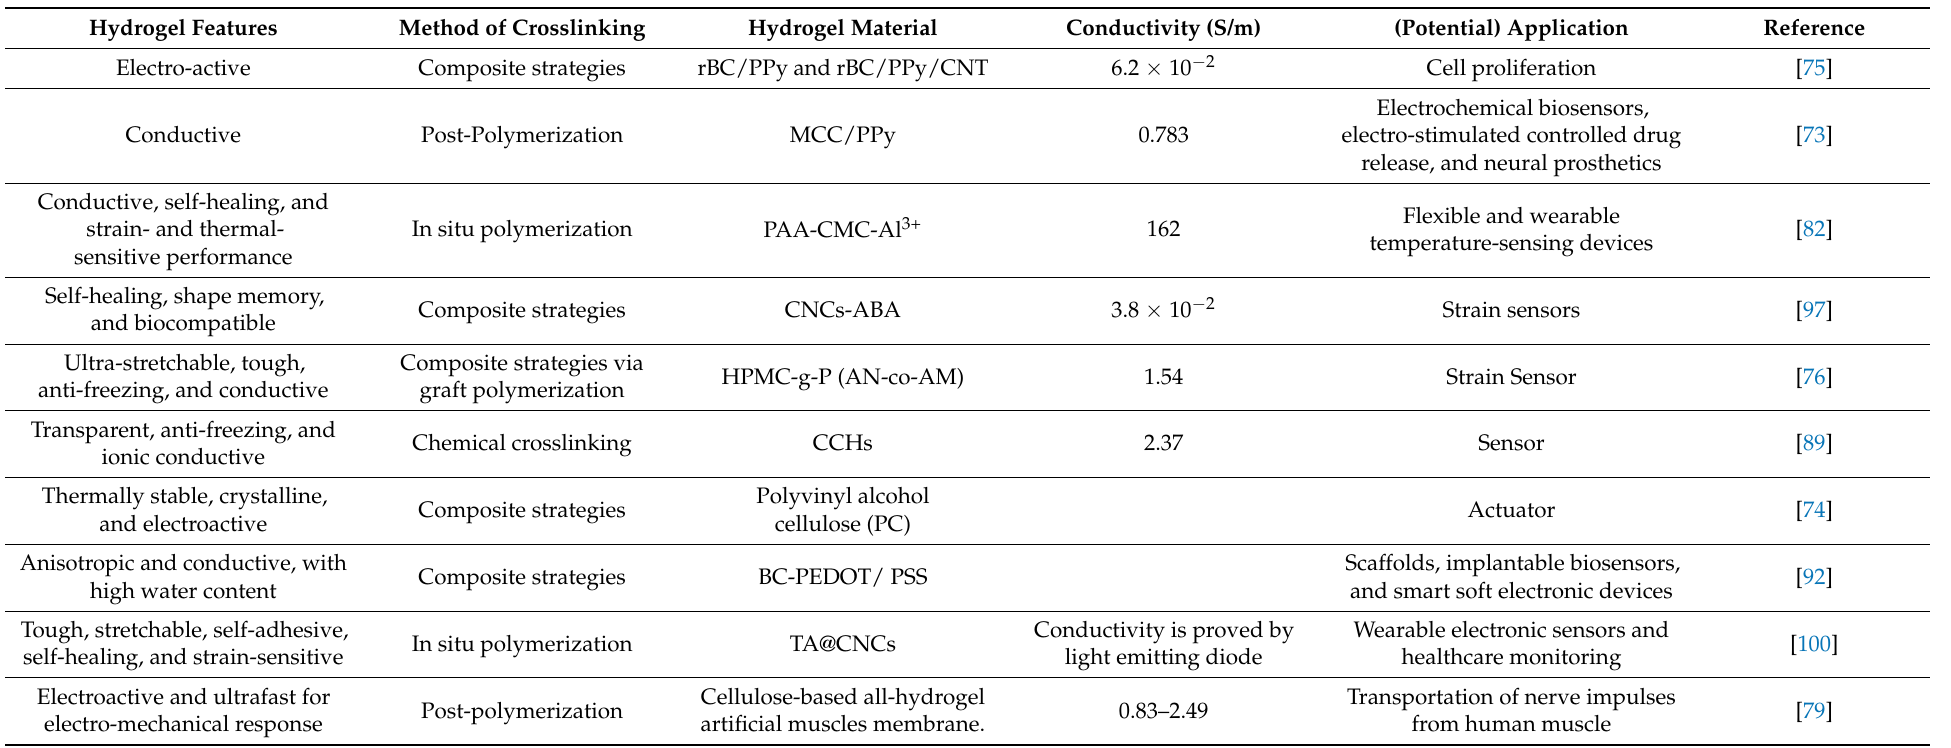
Table 5. Preparation techniques of cellulosic-based conductive